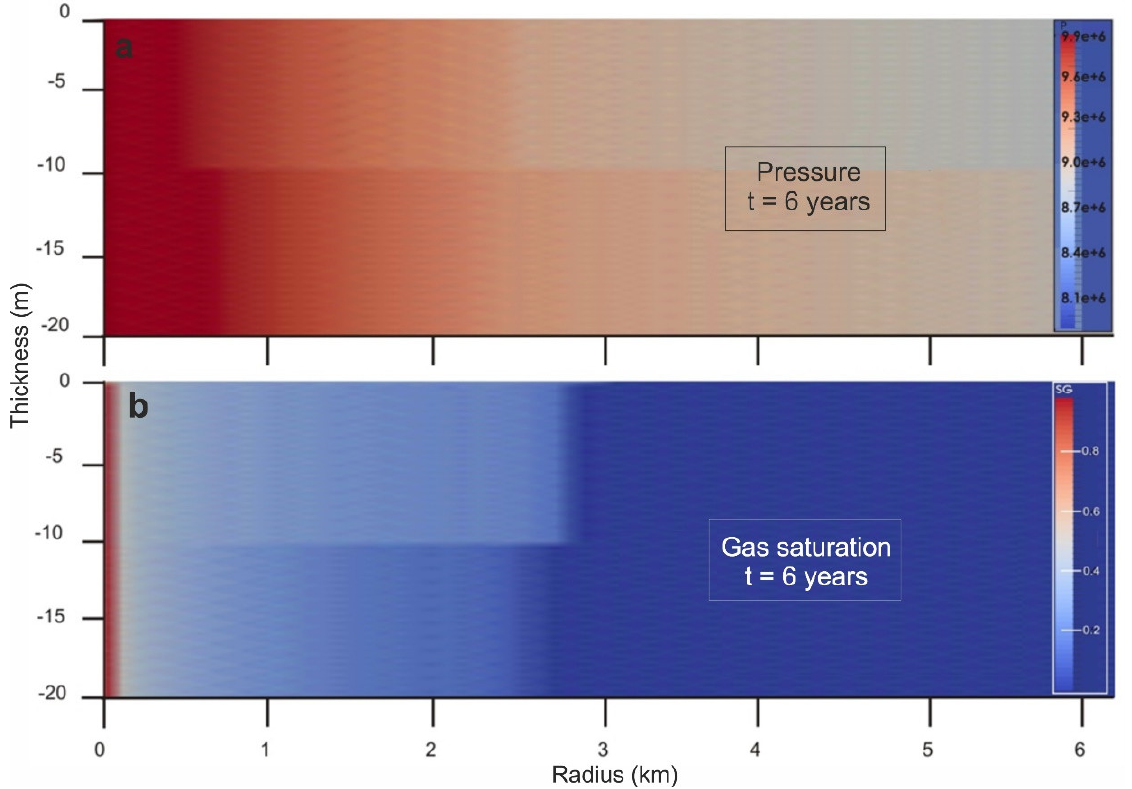
Figure 2. Evolution of the pressure (unit Pa) in the reservoir ( a ) and the gas saturation (forehead of the plume of the injected CO 2 ) after 6 years of injection (scale of the values of CO 2 in the porous medium) ( b ). CO 2 injection started at point 0 on both the x–axis and y–axis.